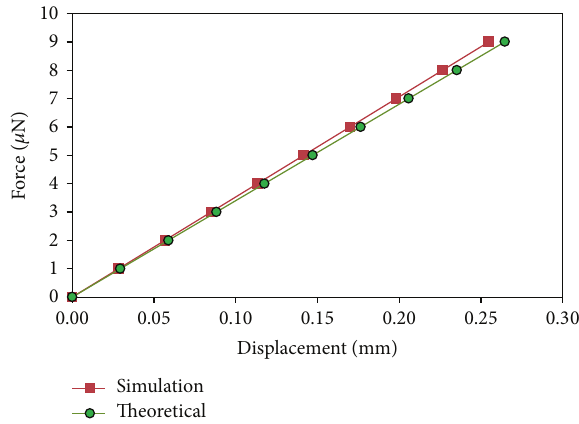
Figure 6: Simulation result of spring displacement with force